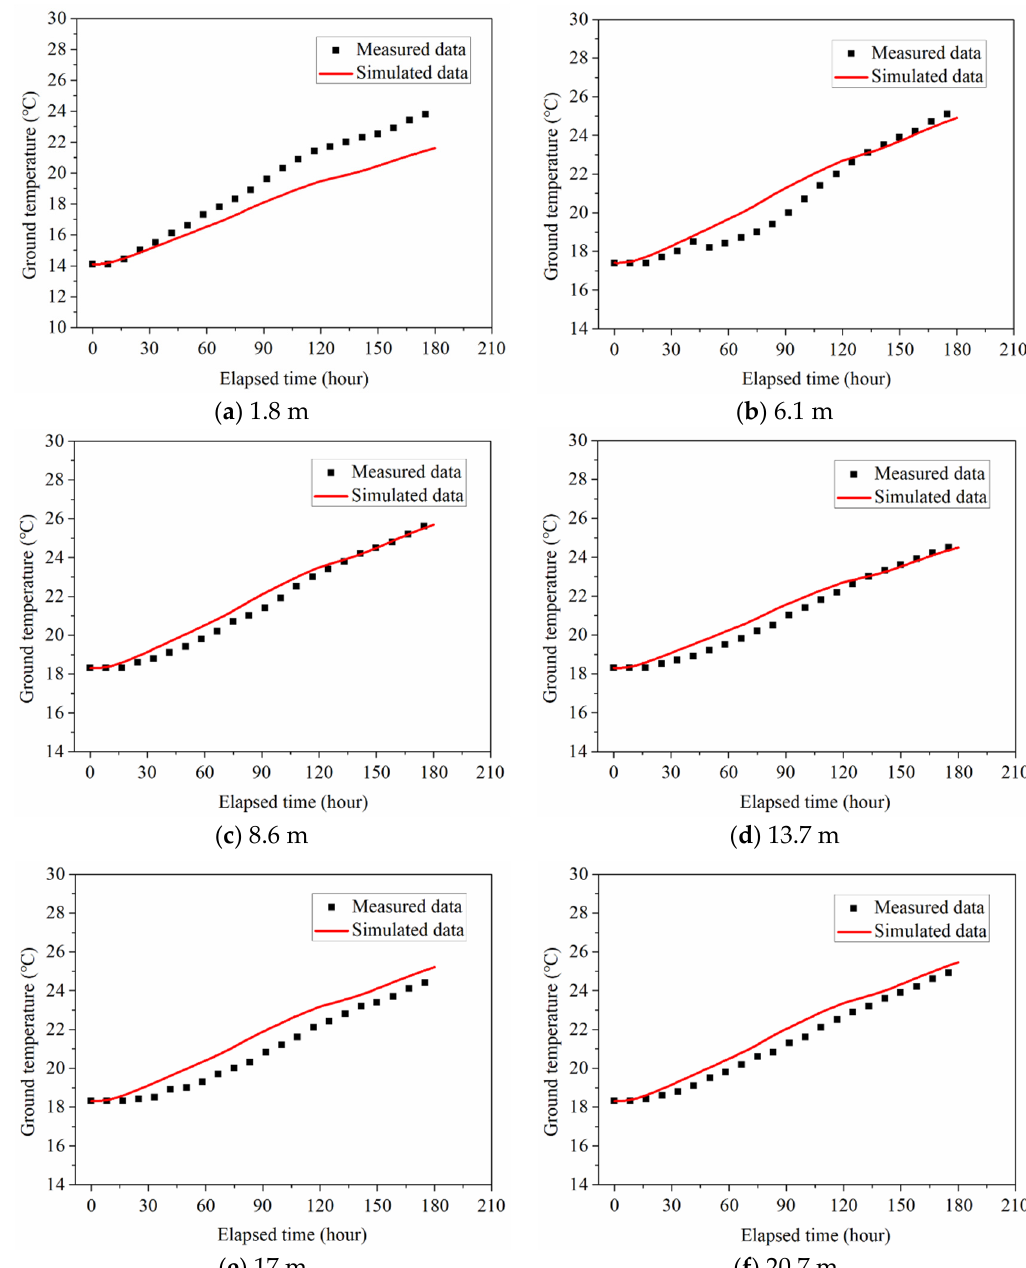
Figure 10. Comparison between the field experimental results and the numerical simulation results.